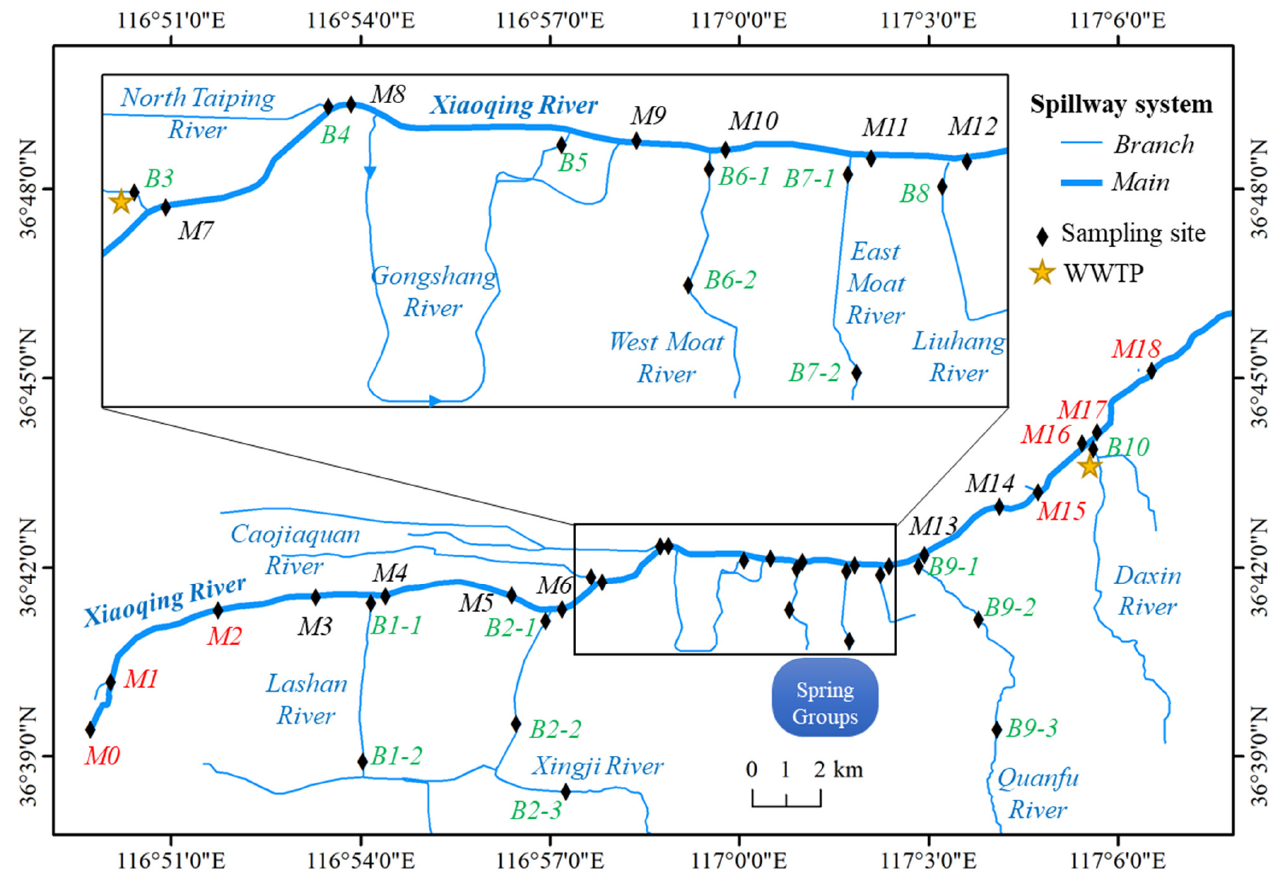
Figure 1. Location of the sampling sites in the urban river system of Jinan, China. Sampling sites with red and black labels are located in the suburban and urban segments of Xiaoqing River, respectively. Sampling sites with green label are located in the branch rivers. WWTP: wastewater treatment plant.